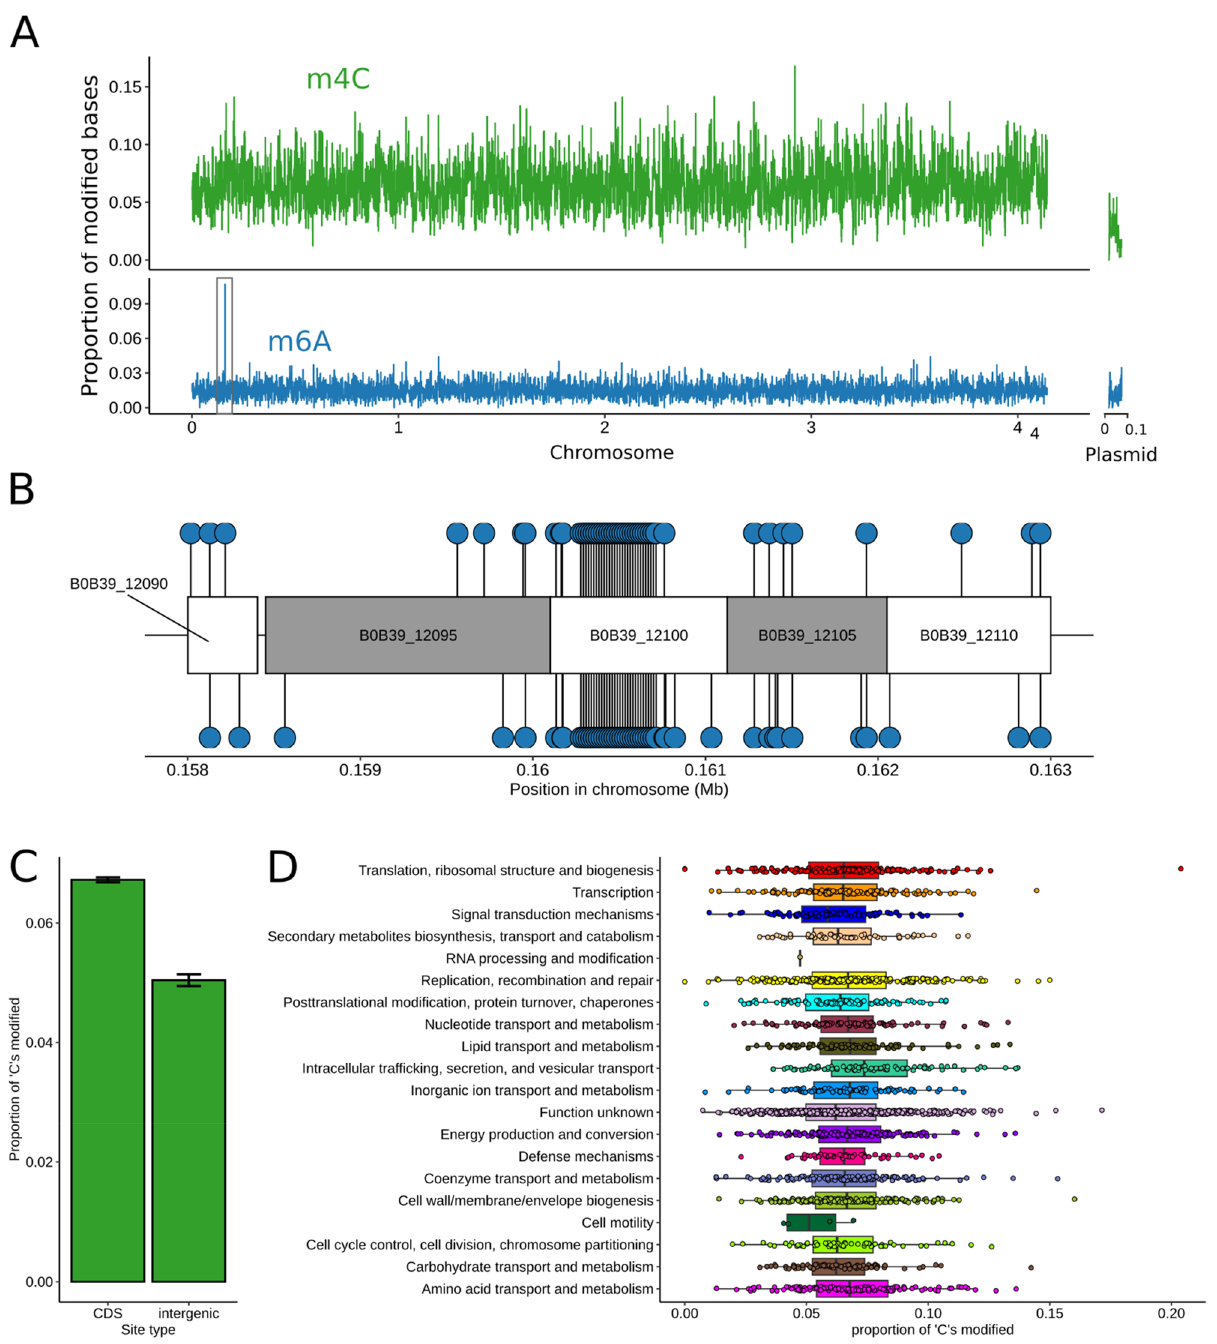
Figure 6. Methyl-distribution and methyl COG. Both methylation marks are approximately evenly distributed across the L. longbeachae genome. ( A ) The frequency with which m 4 C (above in green) and m 6 A (below in blue) modifications were detected is plotted in 1 kb windows, note the difference in y-axes for each sub-plot. The black box represents the region of unusually high m 6 A modifications highlighted in ( B ) and the locations of individual m 6 A modifications are shown as blue circles for the region with an unusually high rate of this mark. The alternating white and grey boxes represent genes in this region, and are labelled with their NCBI locus ID. The gene responsible for the very high rate of m 6 A modification, B0B39_12100, is a tetratricopeptide repeat protein. m 4 C methylation is not strongly associated with any functional class. ( C ) The proportion of ‘C’ nucleotides are with evidence for methylation in coding and intergenic sequences. Error bars represent a 95% confidence interval, calculated using the normal approximation of a binomial distribution. ( D ) Each point represents the proportion of ‘C’ nucleotides in a given gene that show evidence for methylation. The genes are grouped and shaded by the COG category (x-axis). The box plots summarise the distribution of this value across each COG